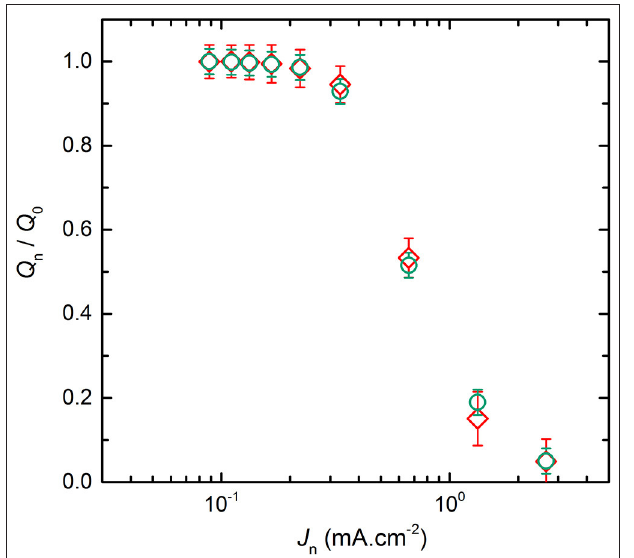
FIGURE 2 | Average normalized capacity, ratio Q n / Q 0 , of the LMP(48-18) battery as a function of the discharge current densities, J n , for the two cycling procedures. The symbols correspond to the ( ♦ ) conventional cycling and ( (cid:13) ) rapid power test.